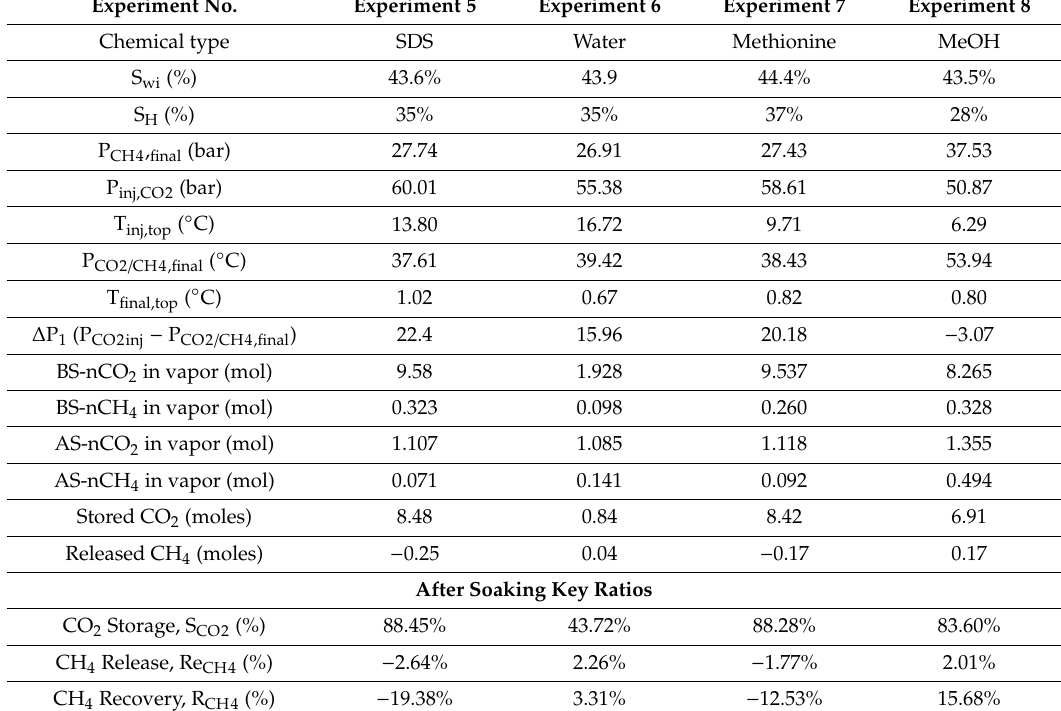
Table 6. Collected experimental data from the CH 4 -CO 2 exchange process and calculated key soaking ratios 24 h after the replacement process (BS = before swapping, AS = after